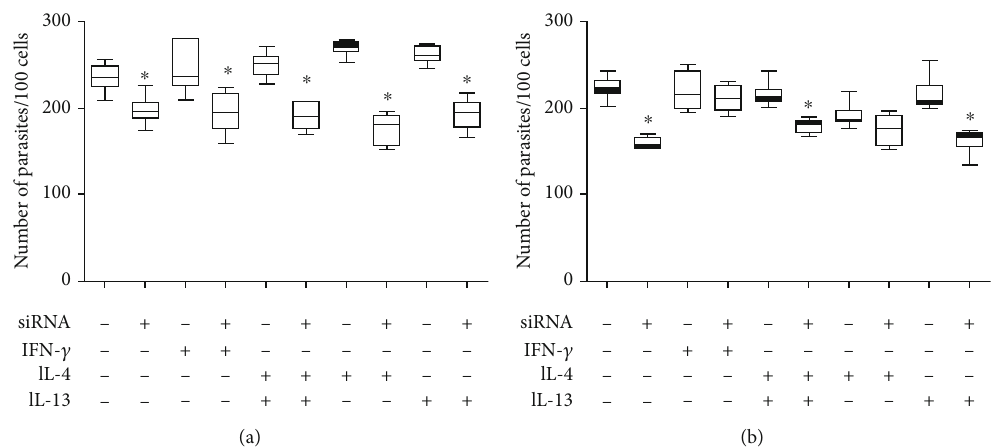
Figure 7: Parasitism in response to cytokine treatments and IGF-I siRNA transfection. Parasitism (median number of parasites per 100 cells) in L. amazonensis -infected RAW 264.7 cells transfected with or without 150 μ M IGF-I siRNA for 6 hours and then were stimulated with IFN- γ (200U/mL; R&D Systems, EUA), IL-4 (2 ng/mL; R&D Systems, EUA), or IL-13 (5 ng/mL; R&D Systems, EUA) for 24 (a) and 48 (b) hours. One representative experiment from three independent assays is shown. ∗ p < 0 : 05 (ANOVA and Tukey ’ s